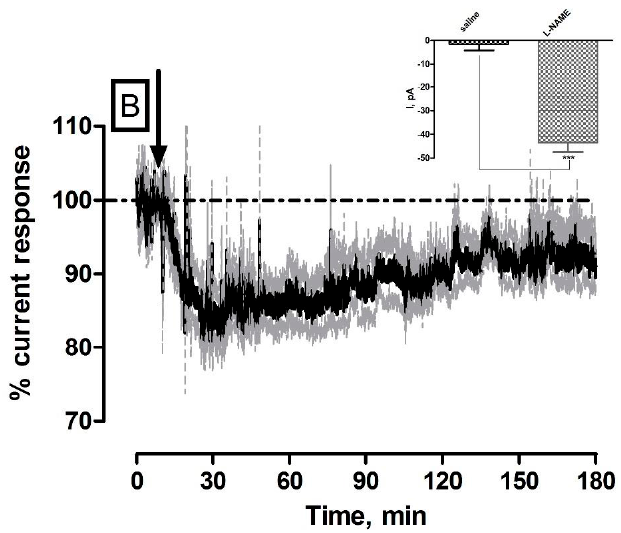
Figure 2. Averaged raw data % current response of ( A ) NO and ( B ) O 2 sensors implanted in the striatum of NOD SCID mice to a 30 mg · kg − 1 injection of L -NAME ( n = 5). Arrows indicate point of injection. Mean % current response represented by black trace, % error represented by grey trace. Insets: Comparison of max current response ( ∆ I) for saline control vs. L -NAME (( A ) NO sensor ( p < 0.05), unpaired t -test ( n = 5) and ( B ) O 2 sensor ( p < 0.001), unpaired t -test ( n = 5)). Data represented as ∆ I ± SEM as compared to baseline. * denotes level of significance.